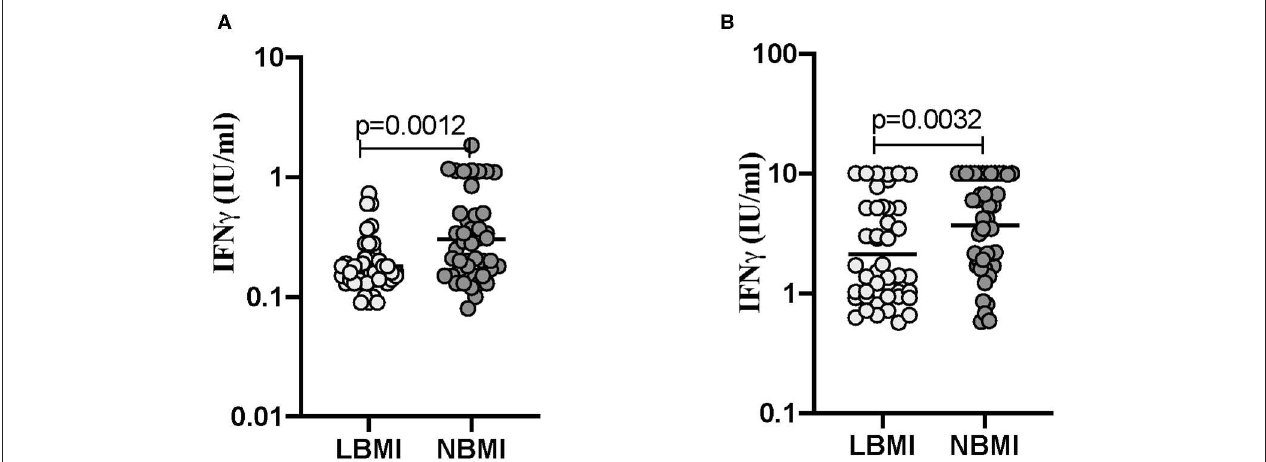
FIGURE 4 | Low BMI is associated with diminished IFN γ levels at baseline (unstimulated) and following TB-antigen stimulation. The baseline (unstimulated) and TB - antigen stimulated IFN γ levels were measured by QFT ELISA in LTBI-LBMI ( n = 44) and LTBI-NBMI ( n = 44) individuals. The data are depicted as scatter plots and each circle represents a single person. Mann–Whitney U -test was done to calculate p -values. (A) Baseline (unstimulated). (B) TB-Ag